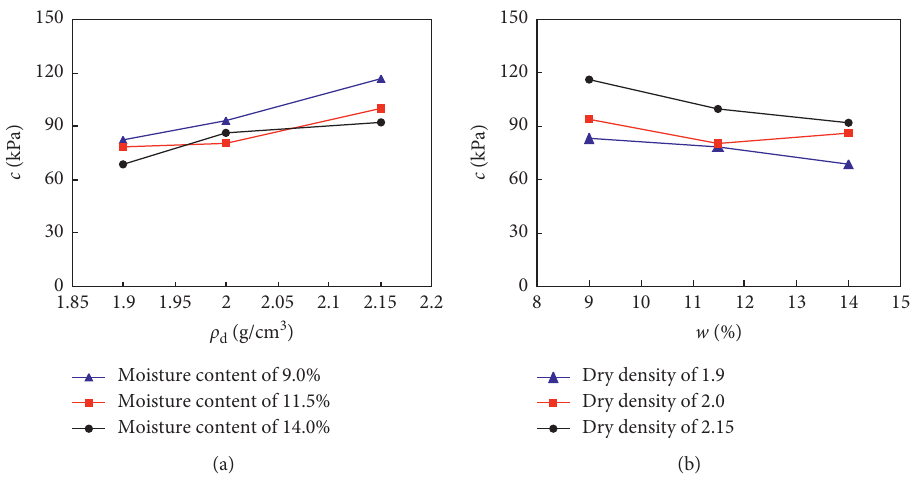
Figure 11: (a) Variations of cohesion ( c ) with dry density ( ρ